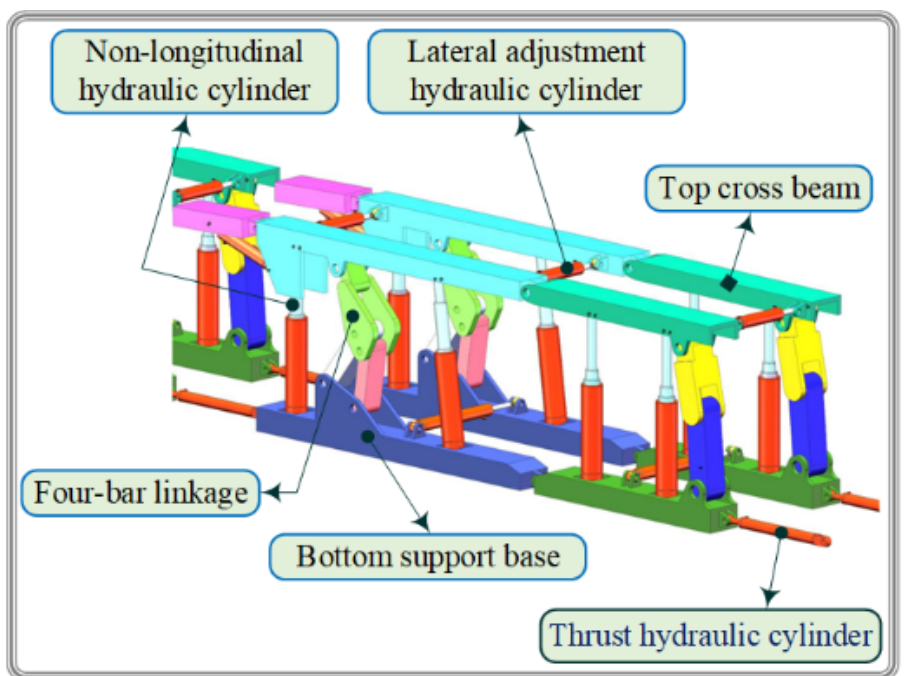
Figure 3. The detailed mechanical structure of the ESR.